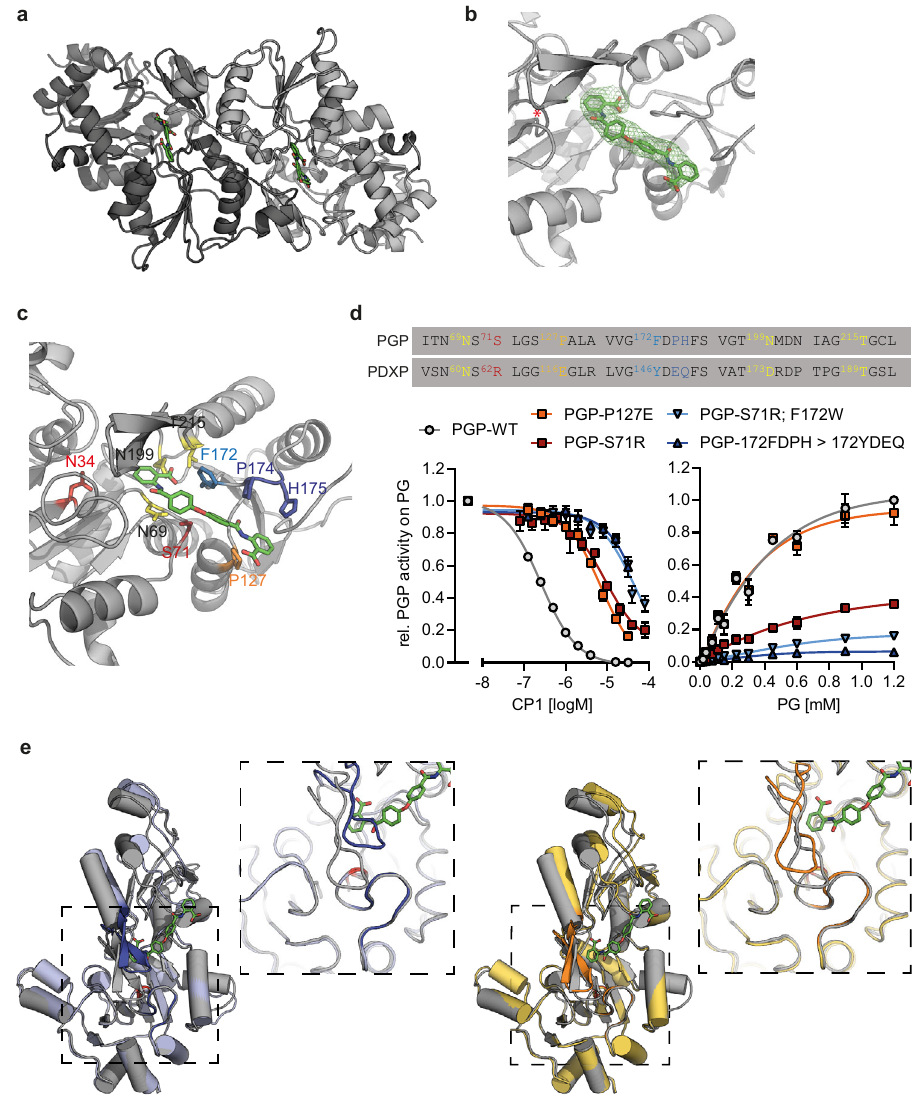
Fig.3|Co-crystalstructureofPGPincomplexwithCP1.a X-raycrystalstructure of homodimeric, full-length murine PGP D34N/C297S bound to CP1 (PDB code 7POE). The two protomers are shown in light or dark grey; CP1 is shown in green. b The F o − F c polder electron density mapof the inhibitoriscontoured atanRMSDof3.0 in green mesh, and superimposed with the re fi ned model. The position of the catalyticAsp/Asn34ishighlightedwitharedstar. c DetailedstructureofboundCP1 andadjacentresiduesoftheactivesite. d Veri fi cationofCP1 – PGPinteractions.The PGP residues highlighted in the alignment were exchanged for the corresponding amino acids of the CP1-insensitive PGP paralog PDXP. Left panel, determination of the IC 50 values of CP1 forpuri fi ed PGP WT orthe indicatedPGP variants.Rightpanel,